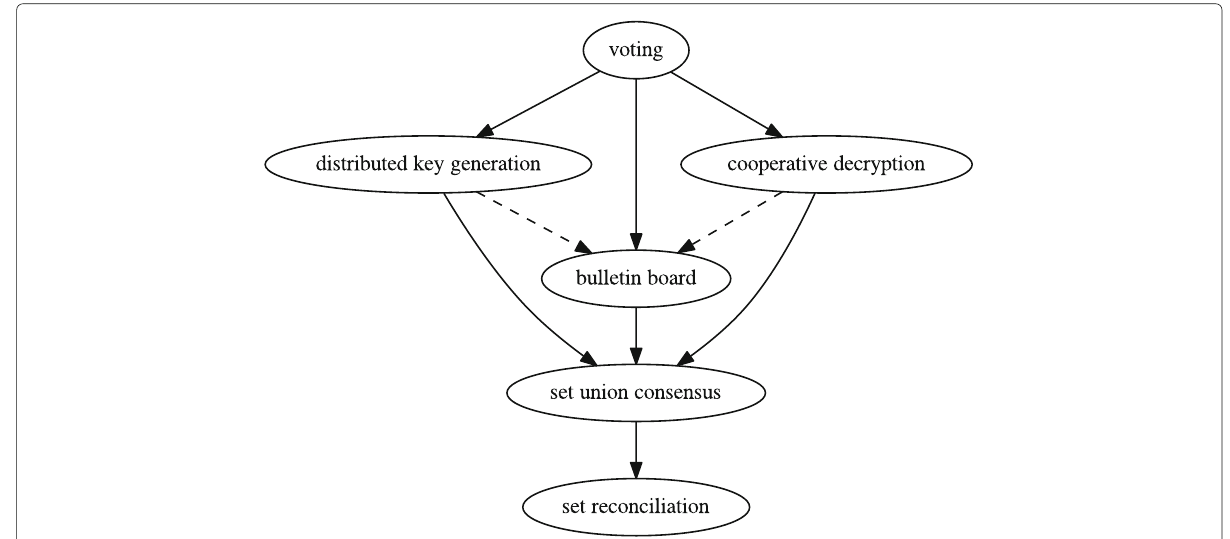
Fig. 12 Relation of different SMC protocols and communication primitives in GNUnet. Dashedarrows indicate optional